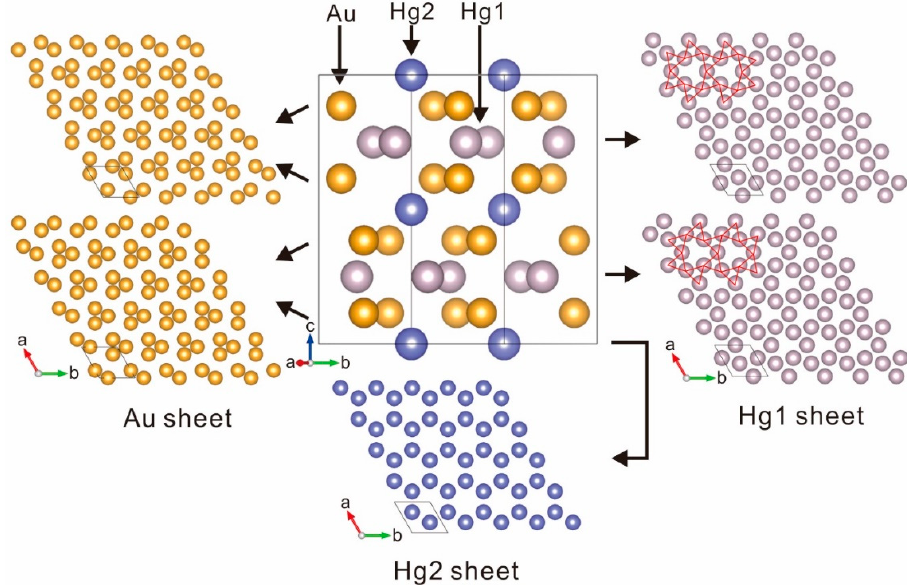
Figure 4. Crystal structure of aurihydrargyrumite.